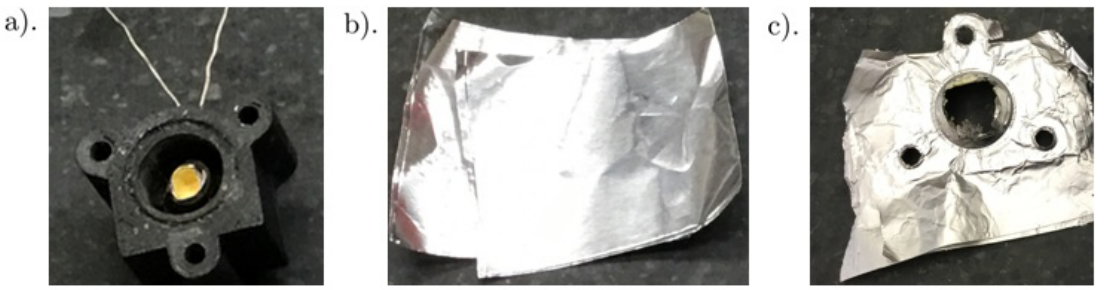
Figure 4. ( a ) Inside the chamber, the connected heating element holding the aluminum foil cup before enclosure; ( b ) the aluminum 8011 alloy rupture disc before firing; and ( c ) the aluminum 8011 alloy rupture disc after